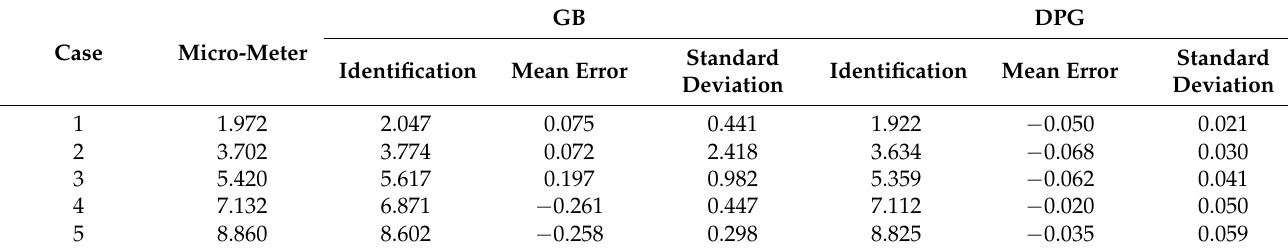
Table 6. Deflection identification at the micrometer 3 (units: